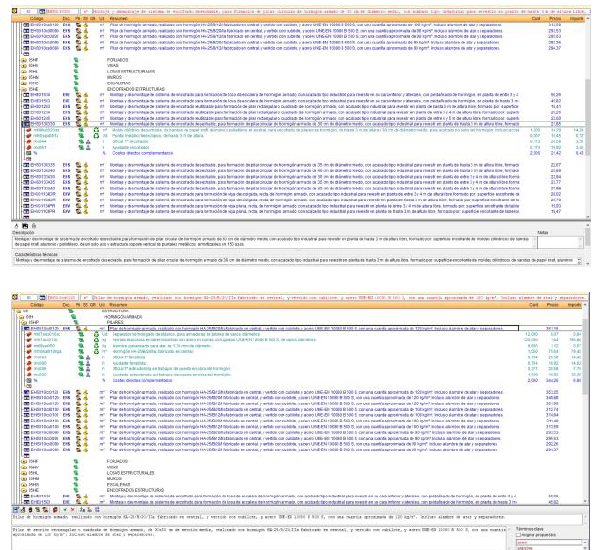
Figure 3. Classification and Propeties of column P37.